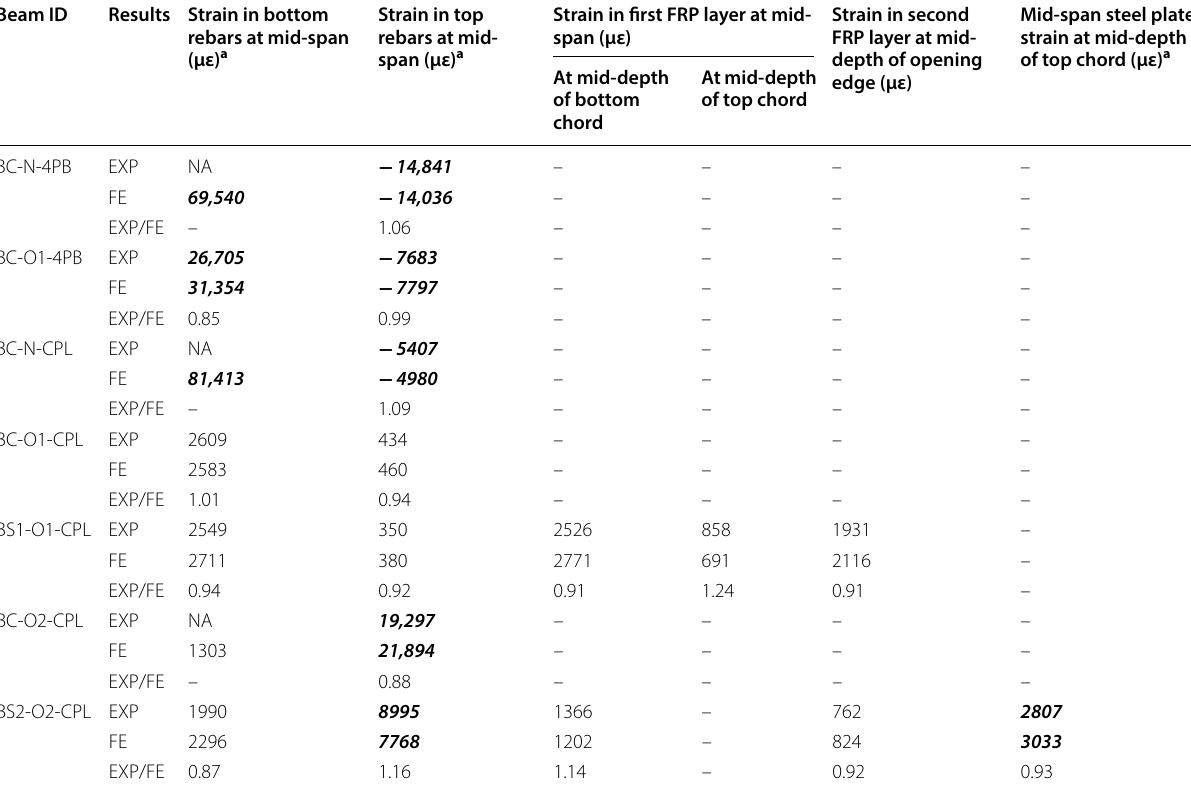
Tensile strain is